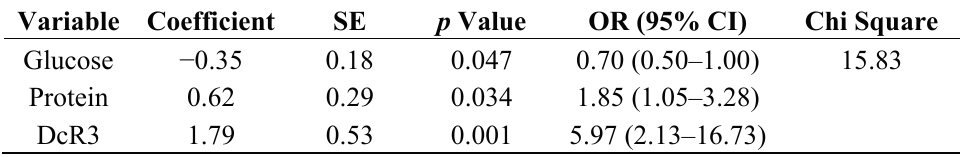
Table 3. Multiple logistic regression analysis of factors used for diagnosing bacterial meningitis. Variable